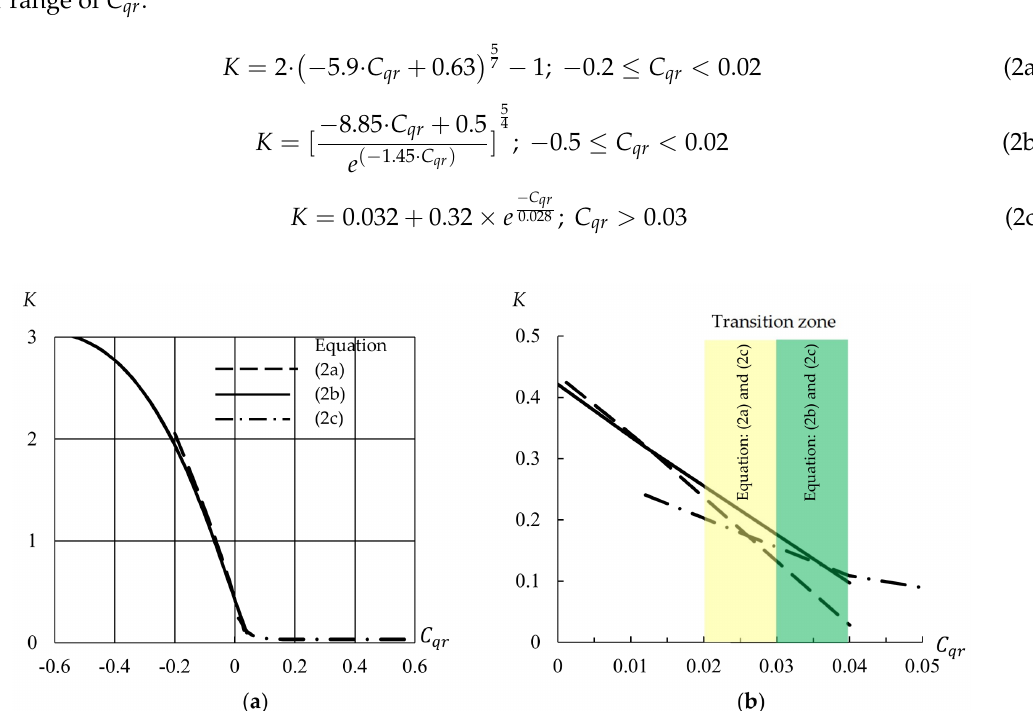
Figure 3. K ( C qr ) curves: ( a ) Equation (2a)–(2c) and ( b ) near the transition zone of the rotation dominant flow and the through-flow dominant flow. K : core swirl ratio at ζ = 0.5; C qr : local flow rate